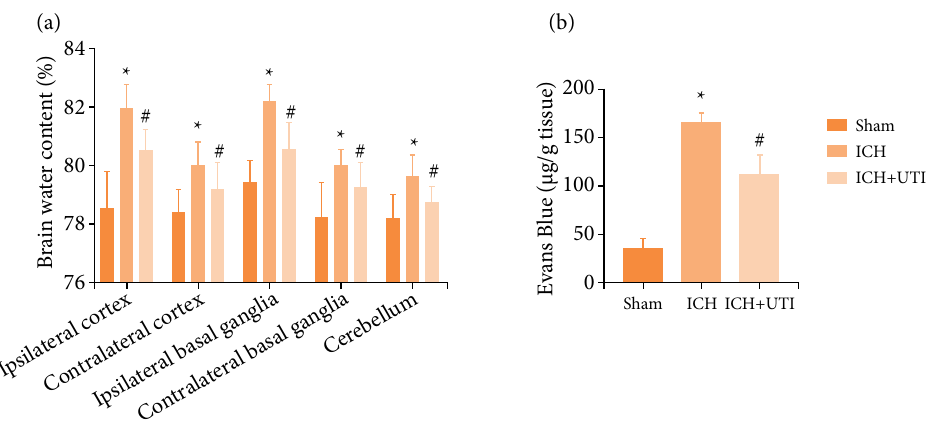
Figure 2 - UTI alleviate brain edema and BBB permeability after ICH. (a) UTI alleviates brain water content after ICH; (b) UTI alleviates BBB permeability after ICH (n = 5, * p < 0.05 vs. Sham; # p < 0.05 vs. ICH; ANOVA; means ±